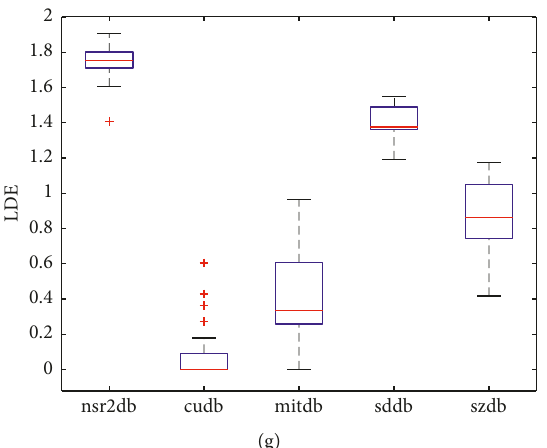
Figure 6: Results of the seven indicators for the five datasets nsr2db, cudb, mitdb, sddb, and szdb. (a–g) The experimental results of the seven indexes SD1, SD2, S , EI, GI, PI, and LDE, Table 2: The means and standard deviations of SD1, SD2, S , EI, GI, PI, and LDE. Indicator